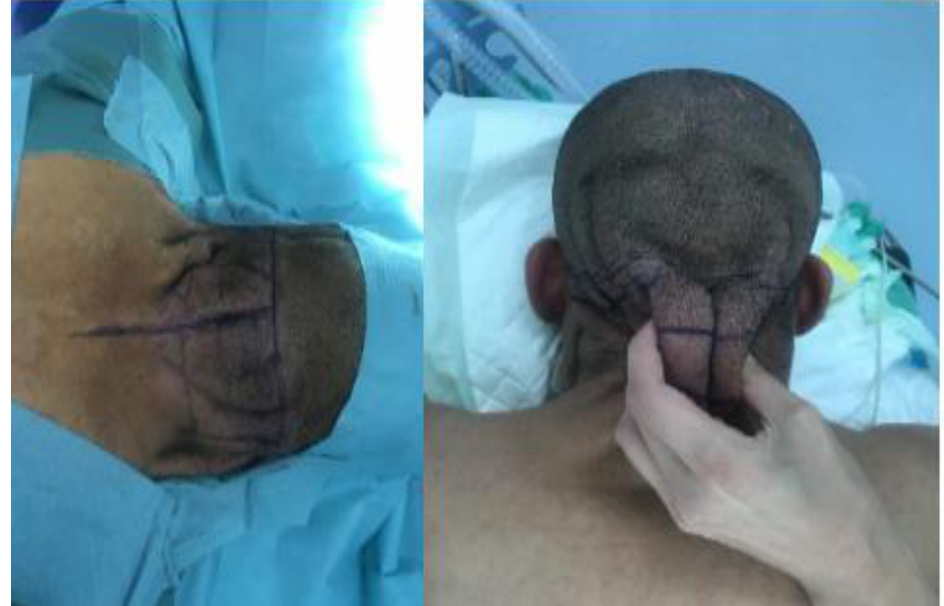
Figure 2. Preoperative drawing was a triangle with an upper base made with a pinch test. The result is in fact the drawing of an “A-T” flap. Furthermore, a schematic view on the A-T plasty is presented in Figure